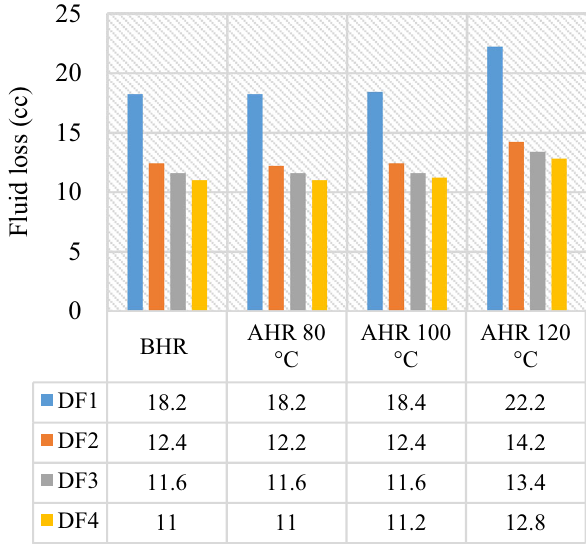
Fig. 4 Thermal stability of CTAB in KCl mud